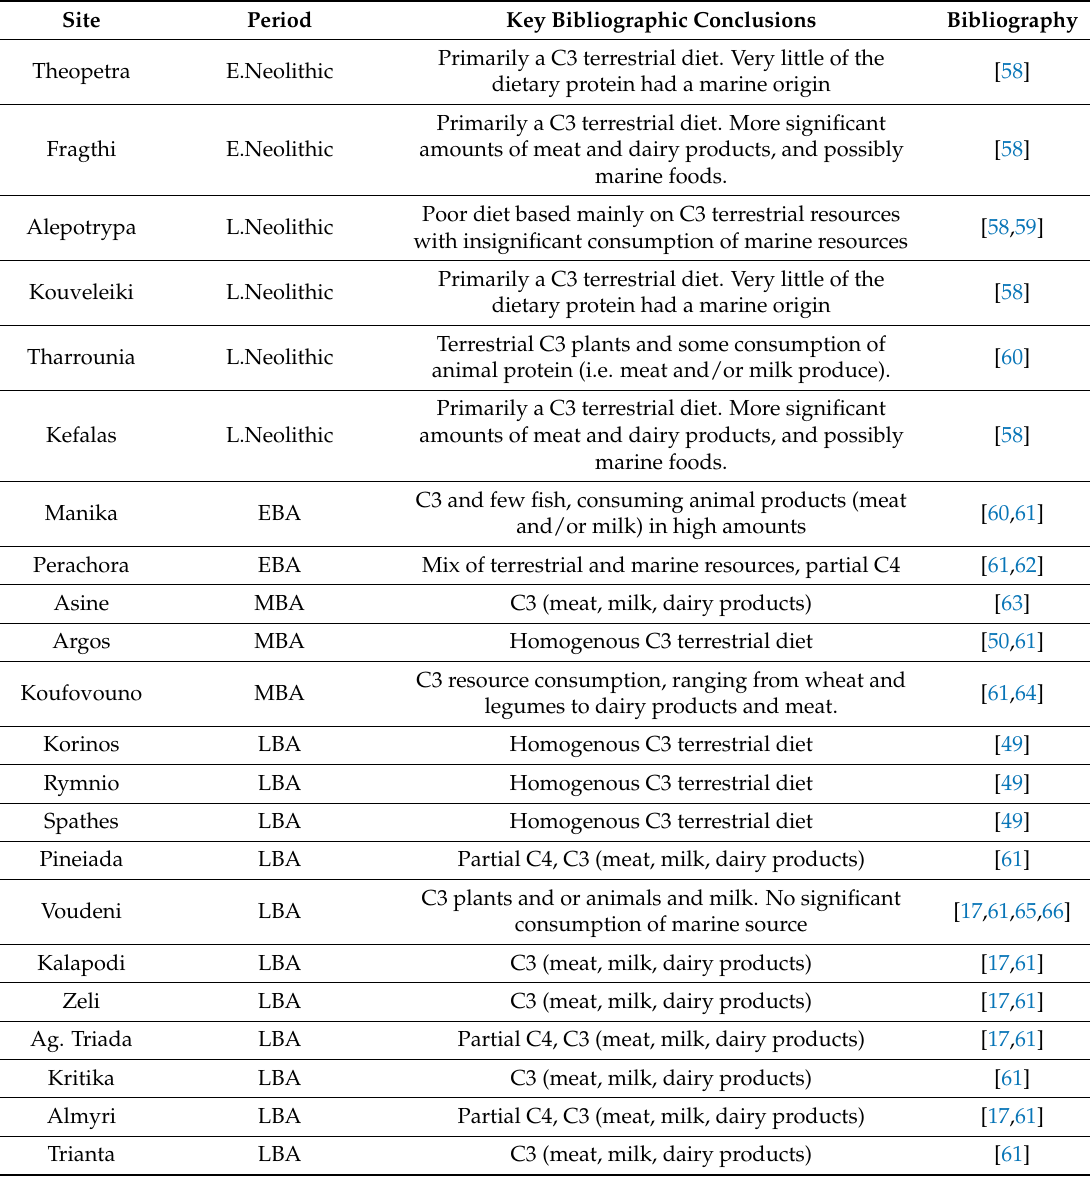
Table 1. Key conclusions for the sites reviewed and relevant bibliography (E. Neolithic: Early Neolithic, L. Neolithic: Late Neolithic, EBA: Early Bronze Age, MBA: Middle Bronze Age, LBA: Late Bronze